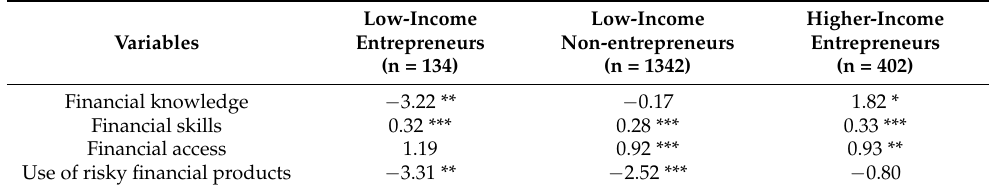
Table 4. Regression analyses to predict financial well-being (N =